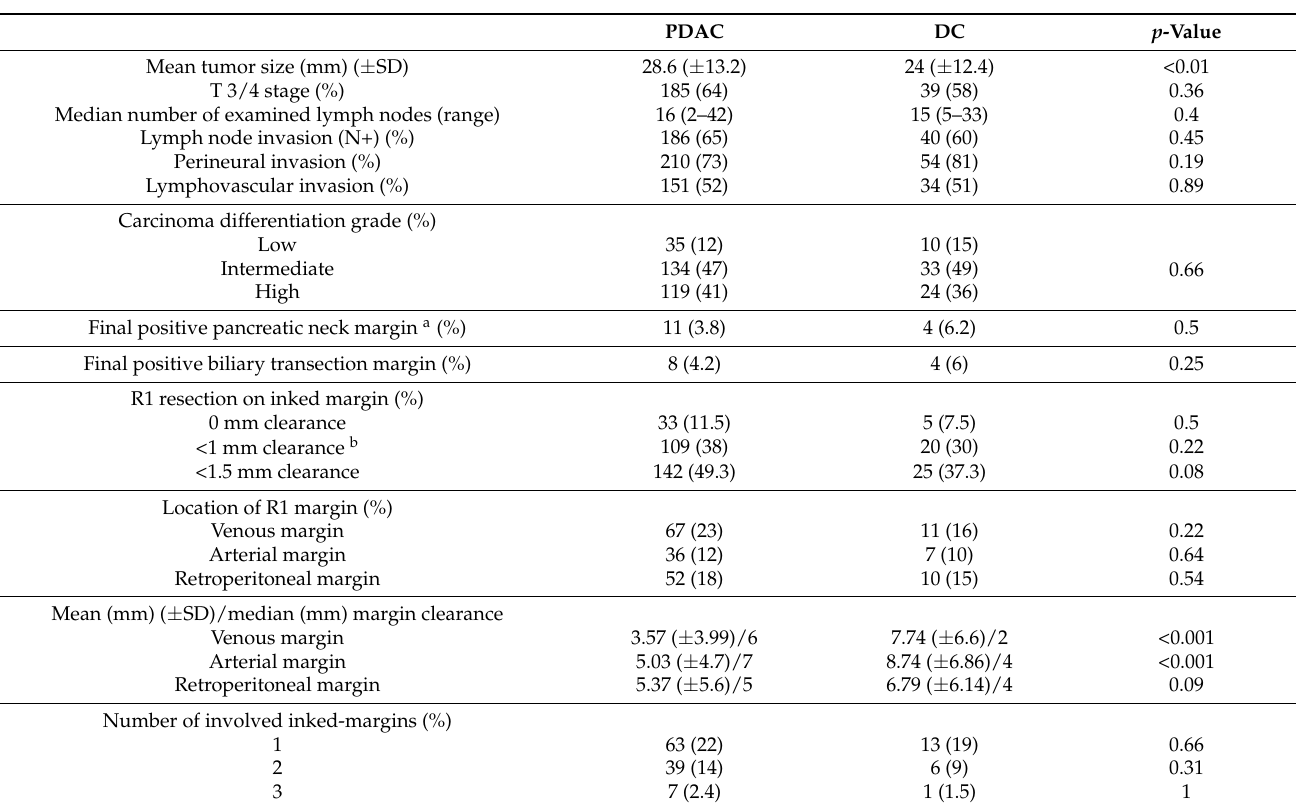
Table 2. Comparisons of pathological features between distal cholangiocarcinoma (DC) and pancreatic ductal adenocarci- noma (PDAC).